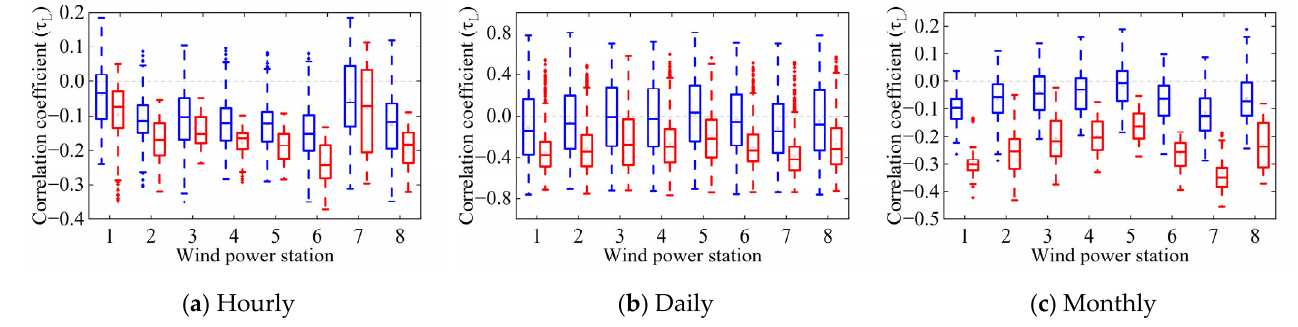
Figure 7. The second type of complementary indicator under different time scales (the blue box represents the wind-wind mode, and the red box illustrates the wind-solar mode).